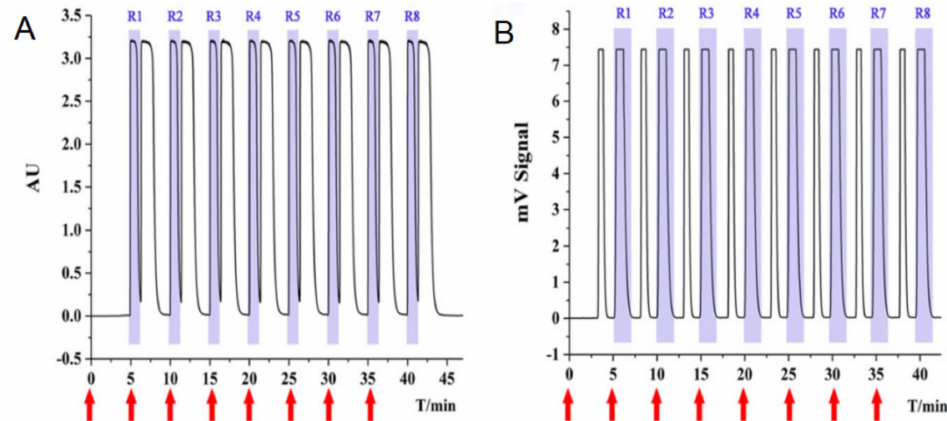
Figure 4. Preparative chromatograms of SKF 93,505 in: ( A ) Liquid chromatography under polar organic mode on Chiralcel OJ column; and in ( B ) Supercritical Fluid Chromatography on Chiralpak AS column. Chromatographic conditions in ( A ): Mobile phase, 100% MeOH; flow rate, 20 mL / min. Chromatographic conditions in ( B ): Mobile phase, CO 2 / MeOH (55:45, v / v ); flow rate, 60 g / min; back pressure: 17.0MPa. Column dimensions (250 × 20 mm, i.d., 10 µ m); sample concentration, 15 mg /